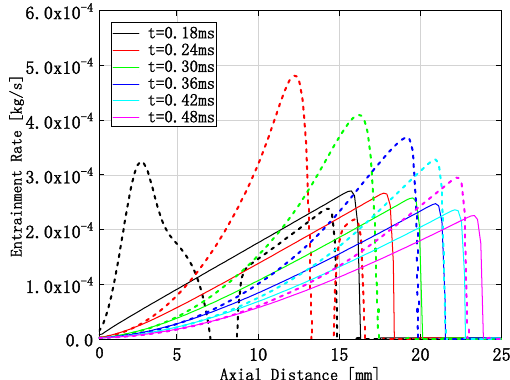
Figure 10. Comparisons of entrainment rate after EOI between the ramping-down single injection and the multiple-injection (solid lines: ramping-down single injection; dotted lines: multiple-injection).